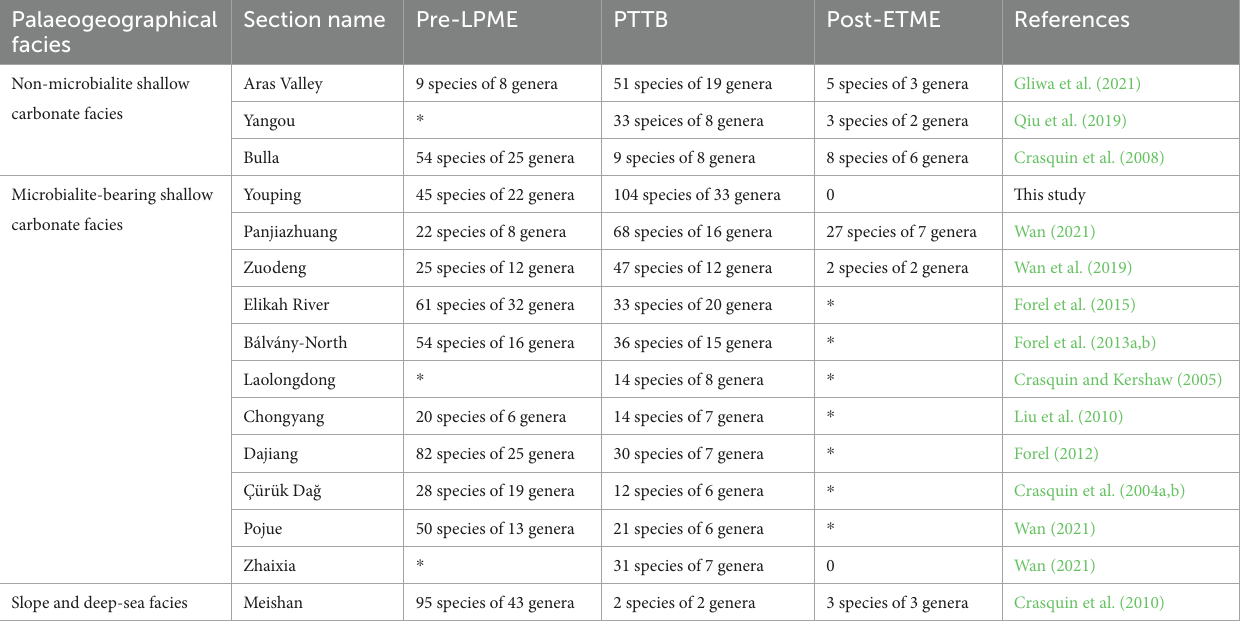
TABLE 1 Taxonomic diversity of ostracods from different sections during the